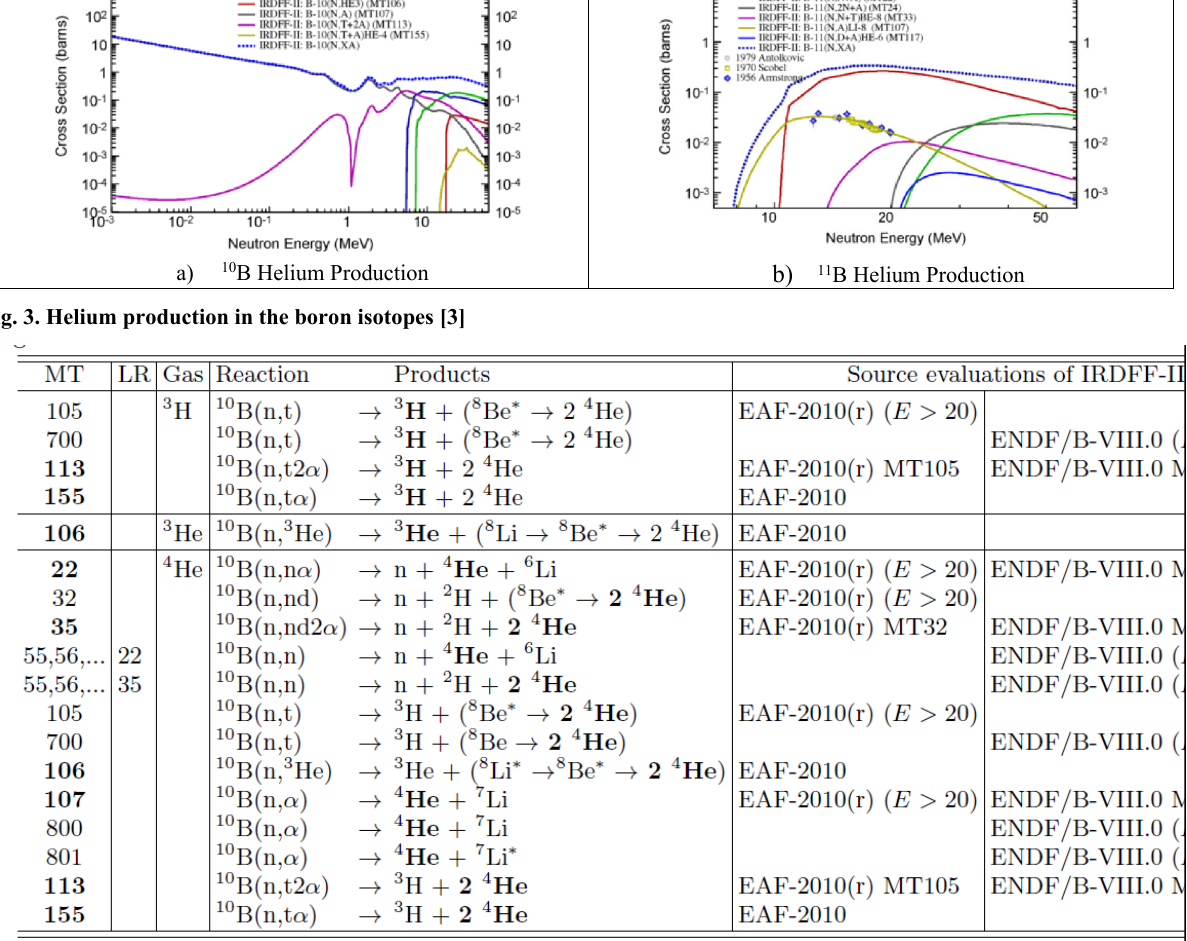
Fig. 4. Complex pathway for helium production in 10 B